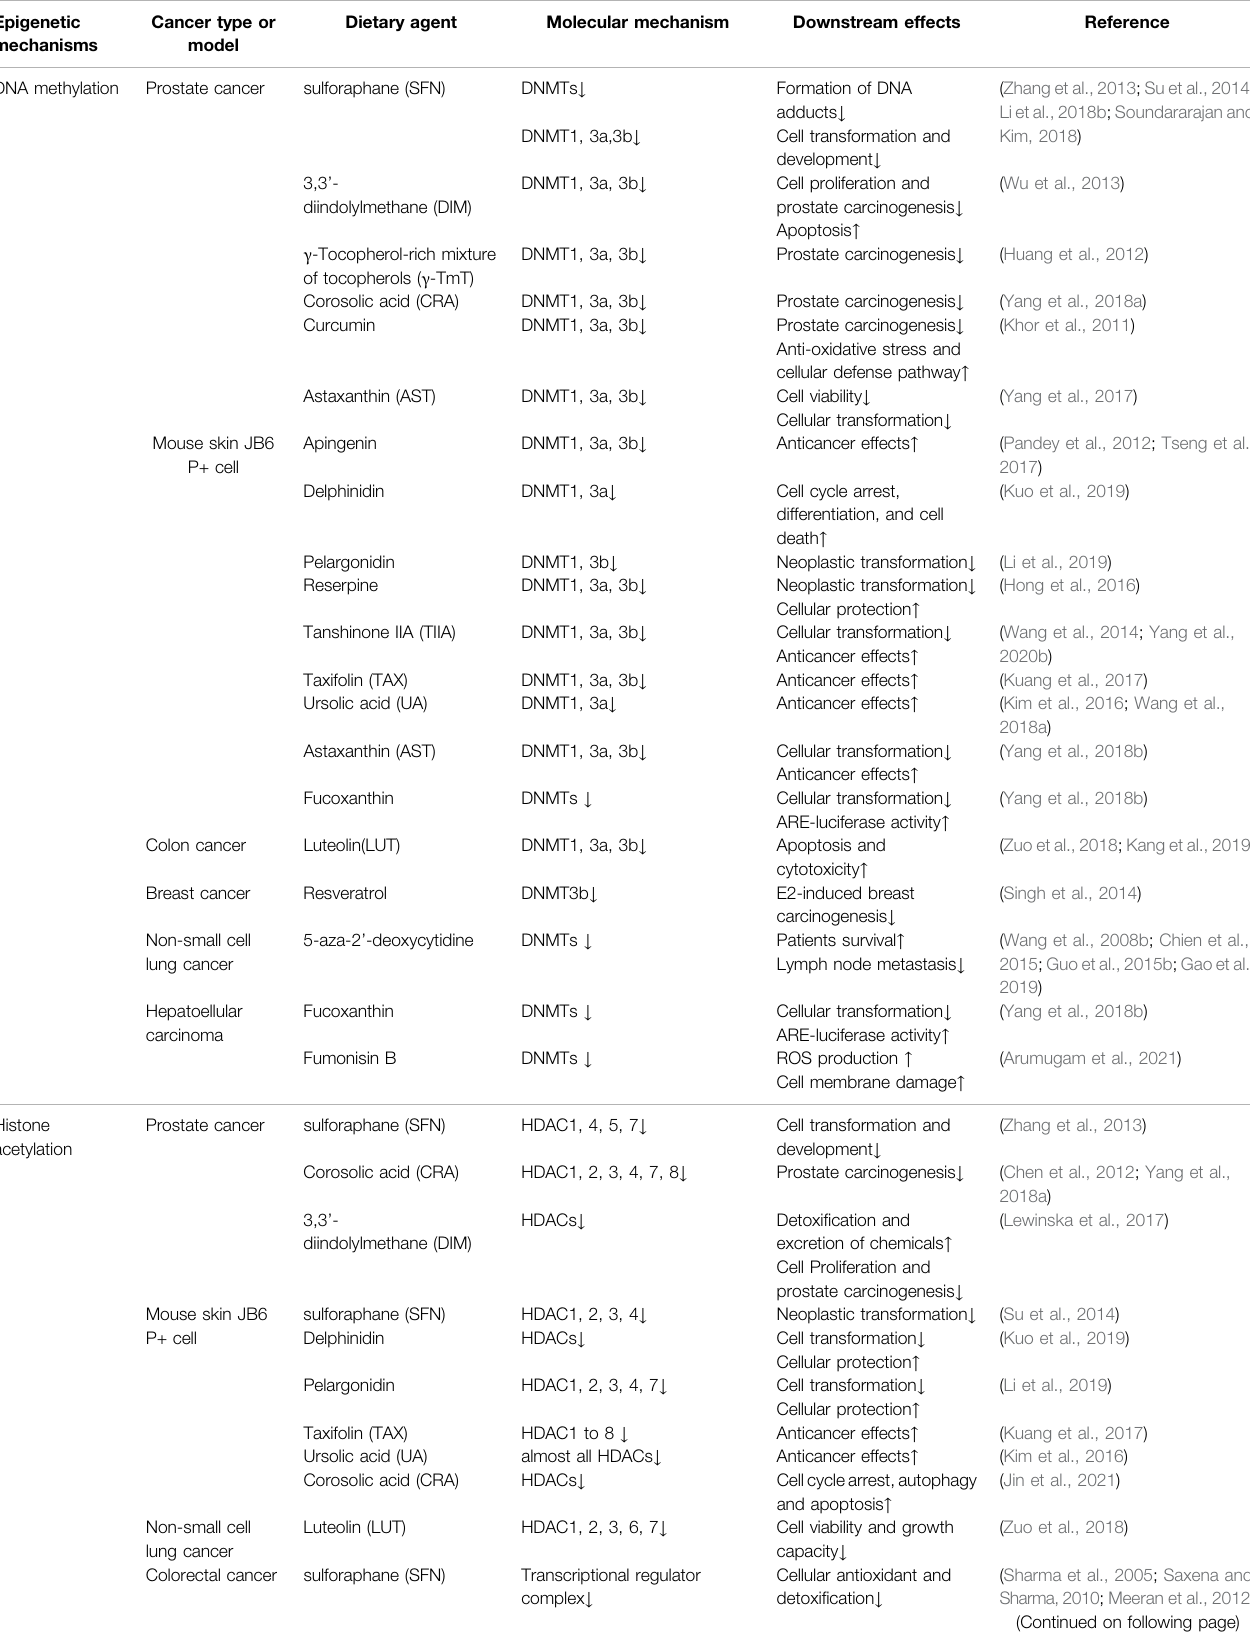
TABLE 1 | Epigenetic modi fi cation and potential targets of NRF2/KEAP1 signaling. Epigenetic